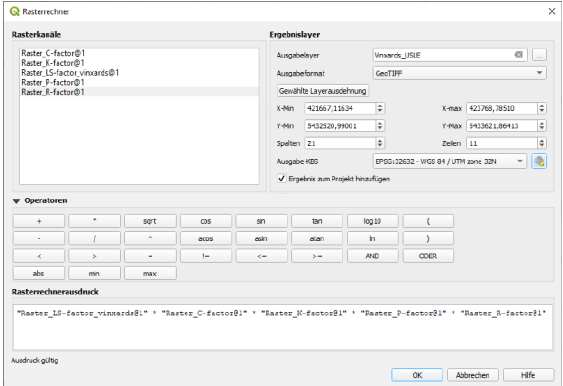
Figure 12. In QGIS applied raster value calculation for the USLE.